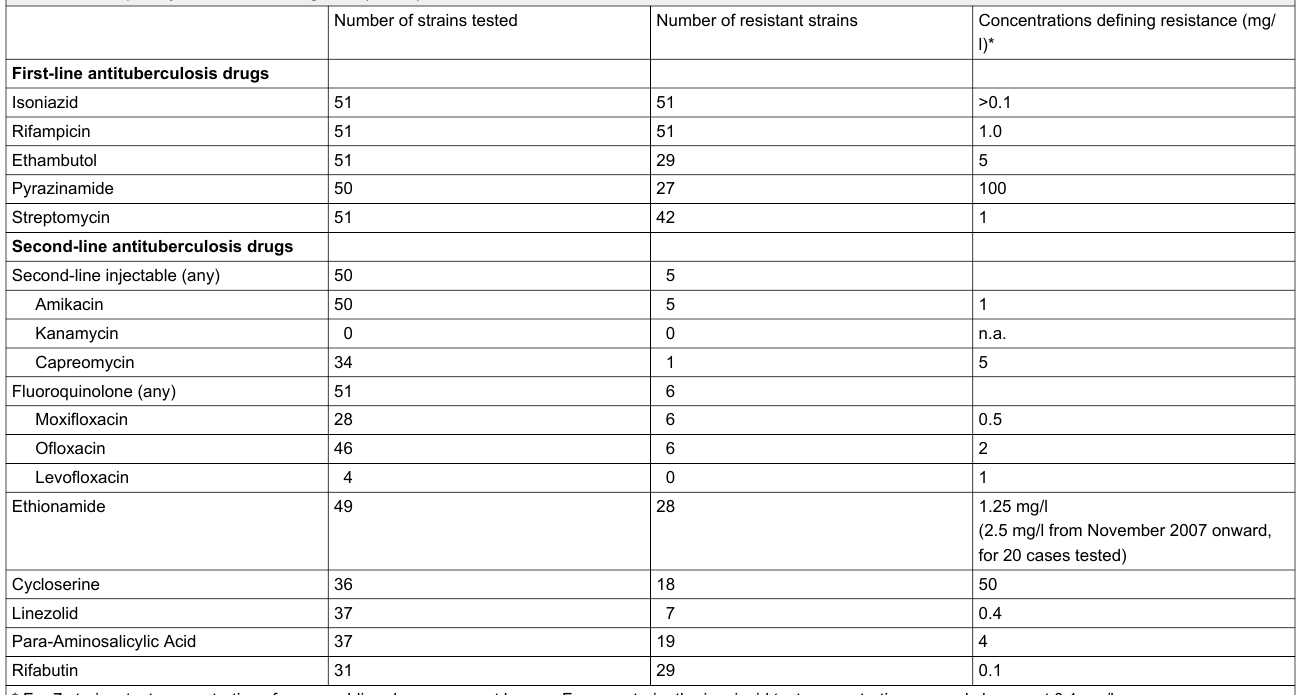
Table 2: Susceptibility test results at diagnosis (n = 51).